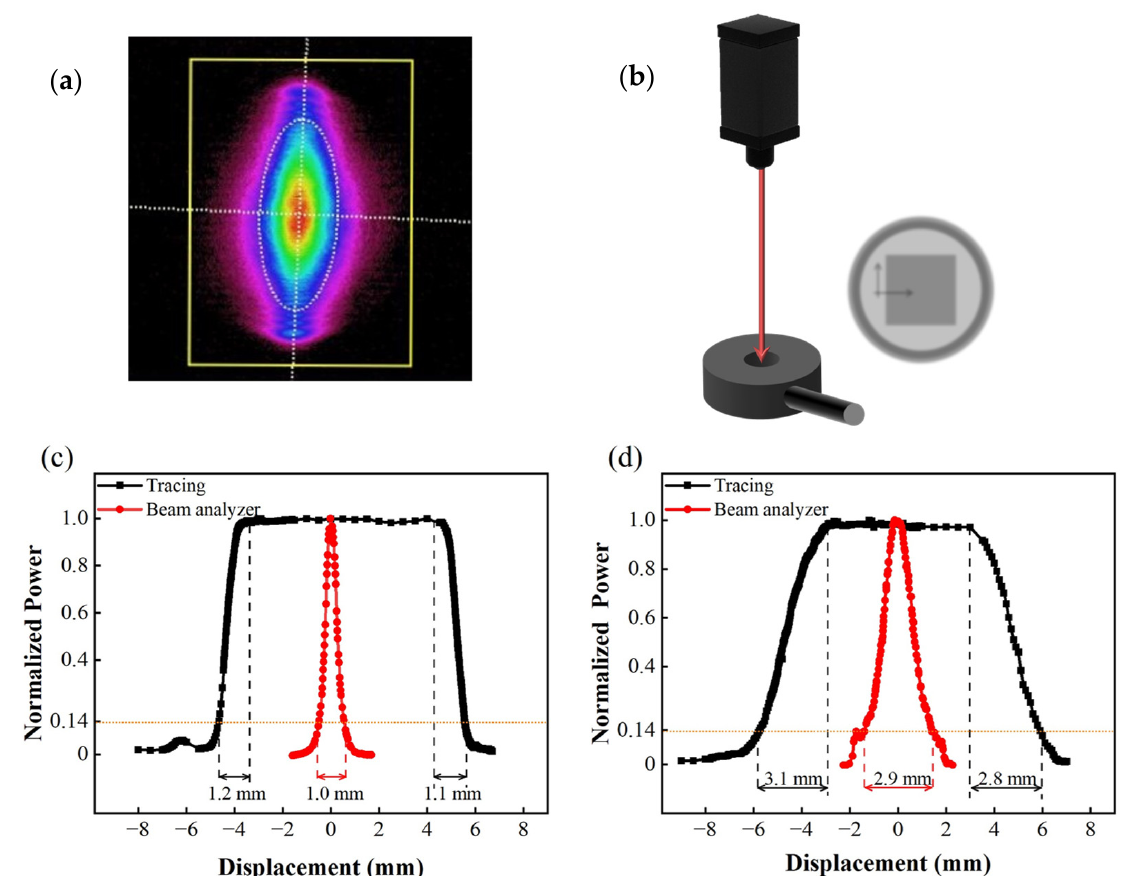
Figure 7. Calibration of spatial distribution of laser power: ( a ) laser spot intensity map; ( b ) sketch of laser spot dimension measurement setup; ( c ) horizontal power distribution; ( d ) vertical power dis- tribution.